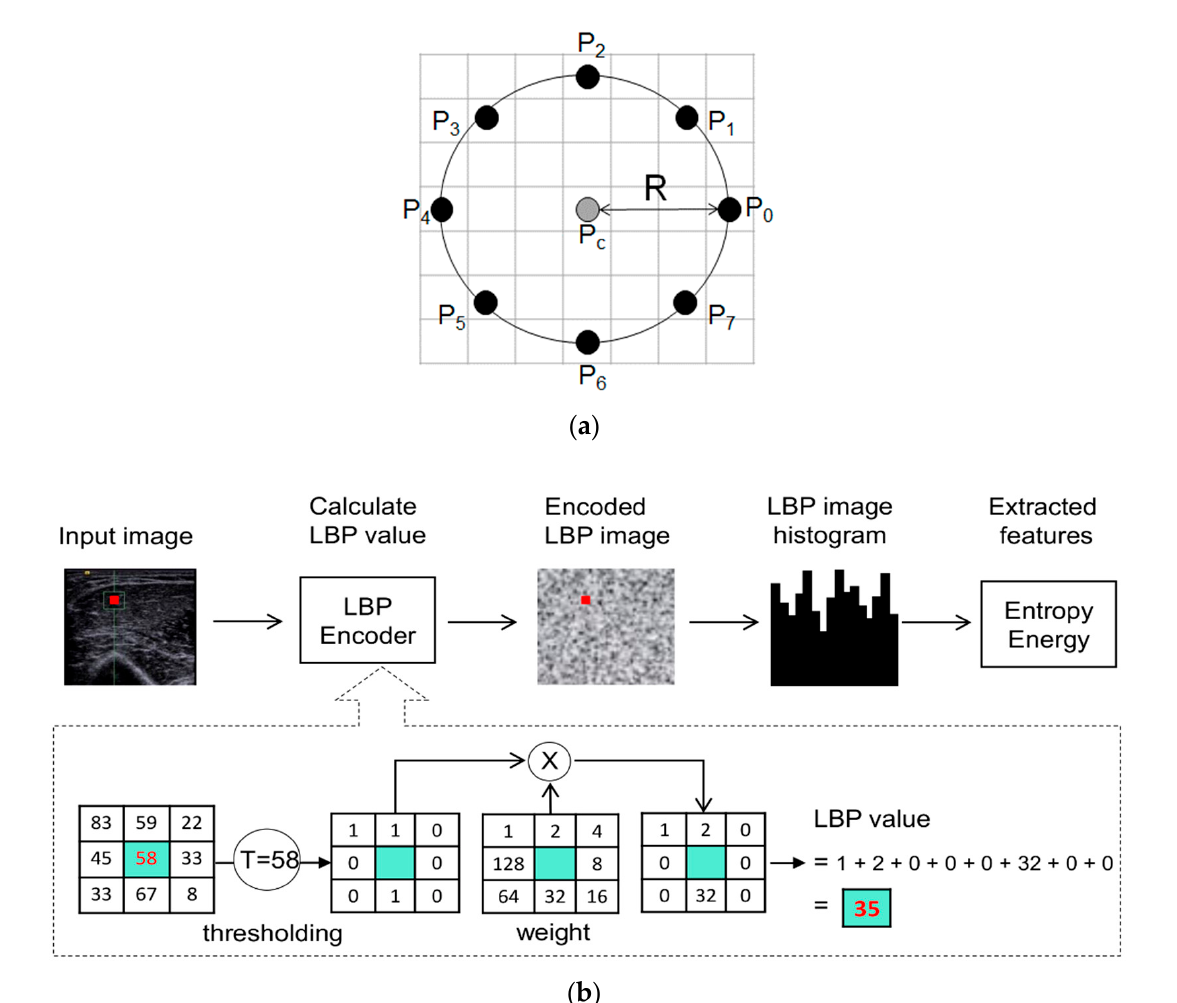
Figure 2. ( a ) Central pixel (Pc) and its P circularity neighbors (P1–P7) with radius R (R = 1, 2, 3); ( b ) of the computation of echotexture feature extraction using the local binary Schematic representation of the computation of echotexture feature extraction using the local binary pattern.